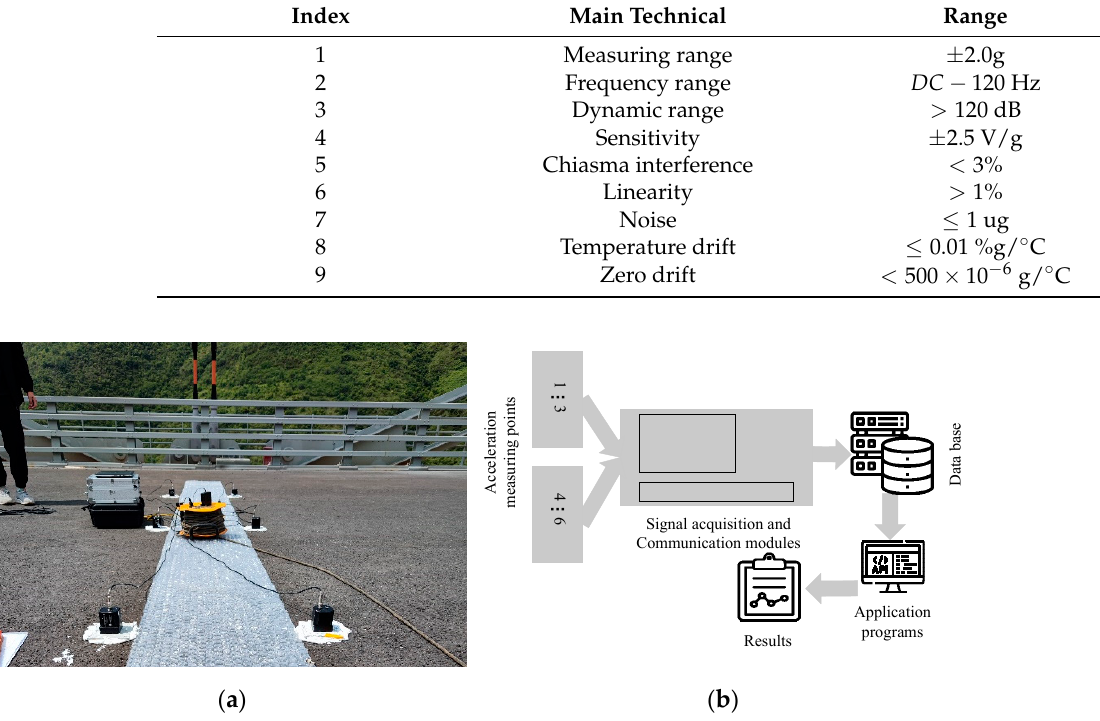
Table 1. Parameters of measurement setup of GT02 force balance accelerometer. Figure 5. Accelerometer sensor layout on Humen Bridge.